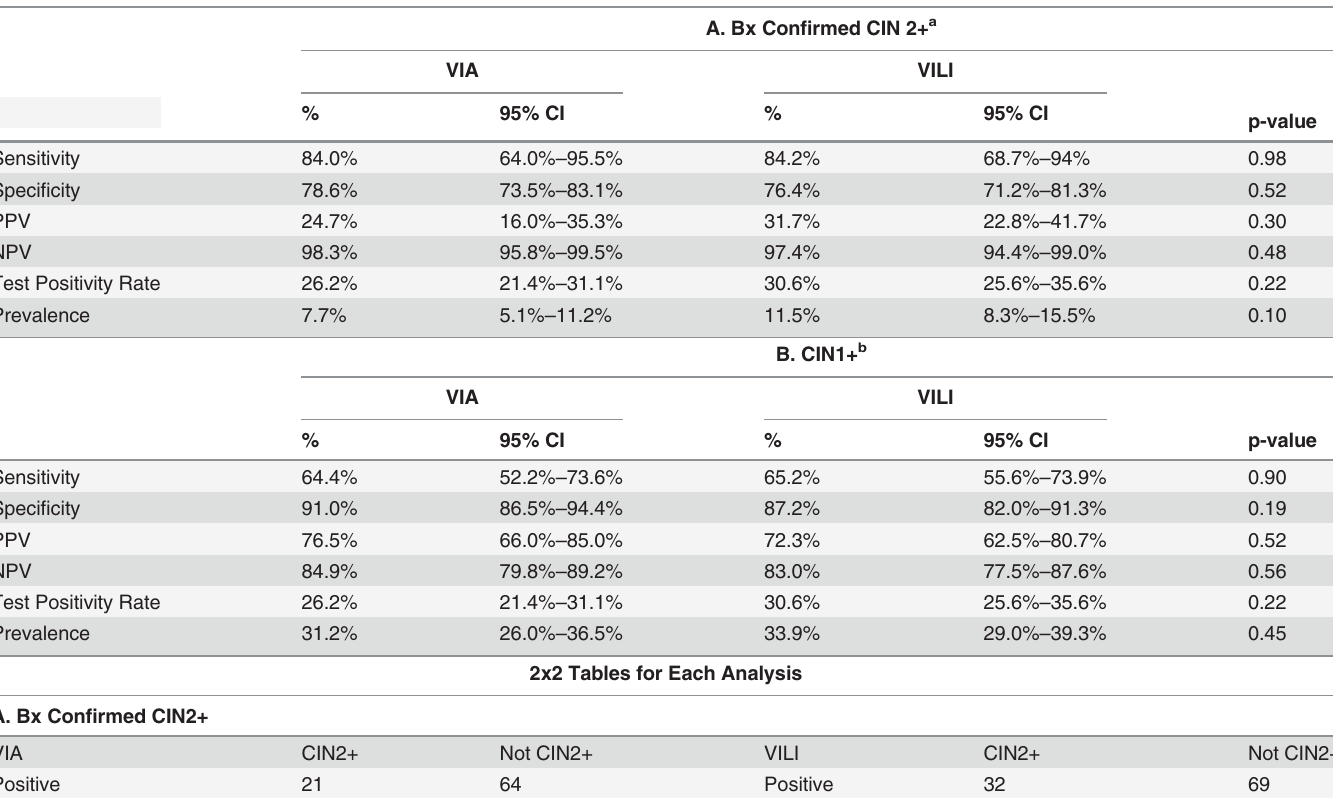
Table 2. Clinical performance of VIA and VILI for diagnosis of